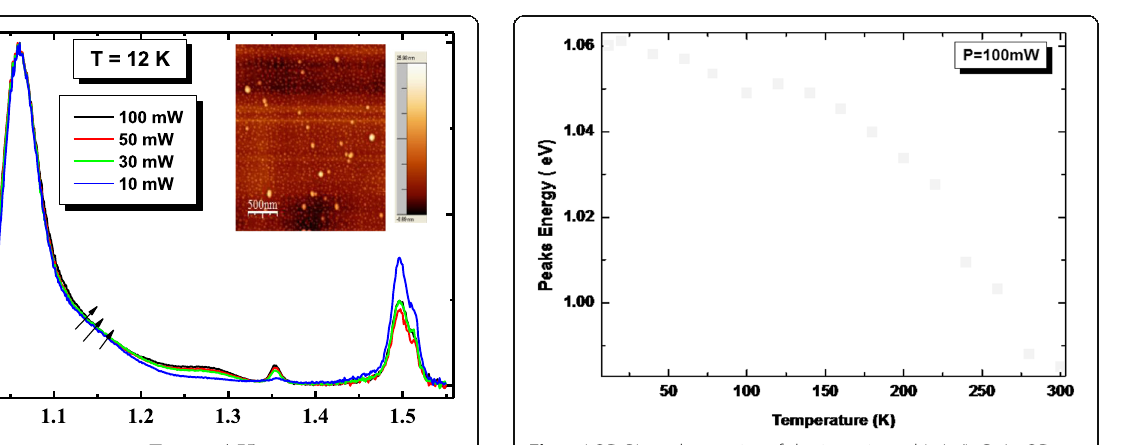
Fig. 7 LQD PL peak energies of the investigated InAs/InGaAs QD heterostructure measured at various